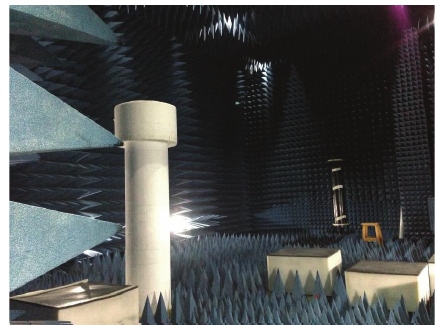
Figure 4: Measurements of radiation patterns in an anechoic